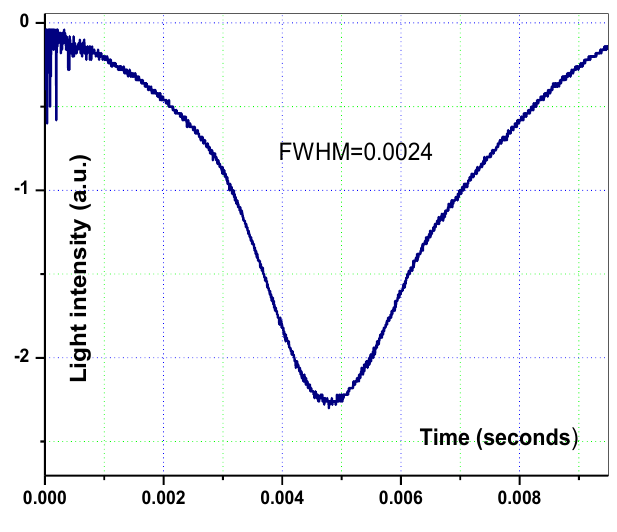
Figure 5. PMT signal of IEC plasma